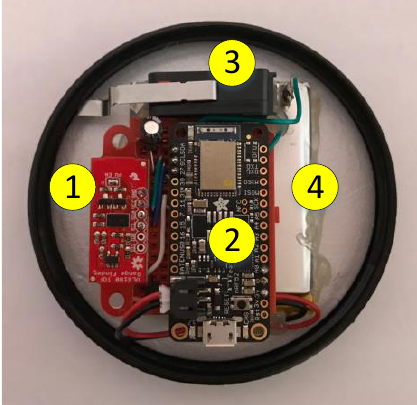
Figure 6. Photograph of the device attached under the canister cap—( 1 ) proximity sensor, ( 2 ) SoC microcontroller with BLE and battery charger, ( 3 ) detector switch, and ( 4 ) Li-Po rechargeable battery. J. Sens. Actuator Netw. 2019 , 8 , x FOR PEER REVIEW